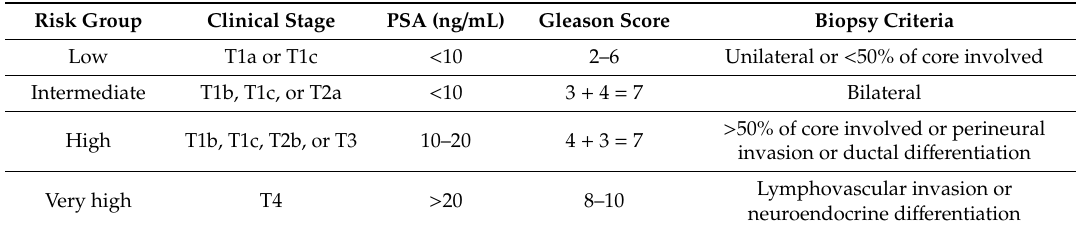
Table 2. Classification of the risk groups of prostate cancer